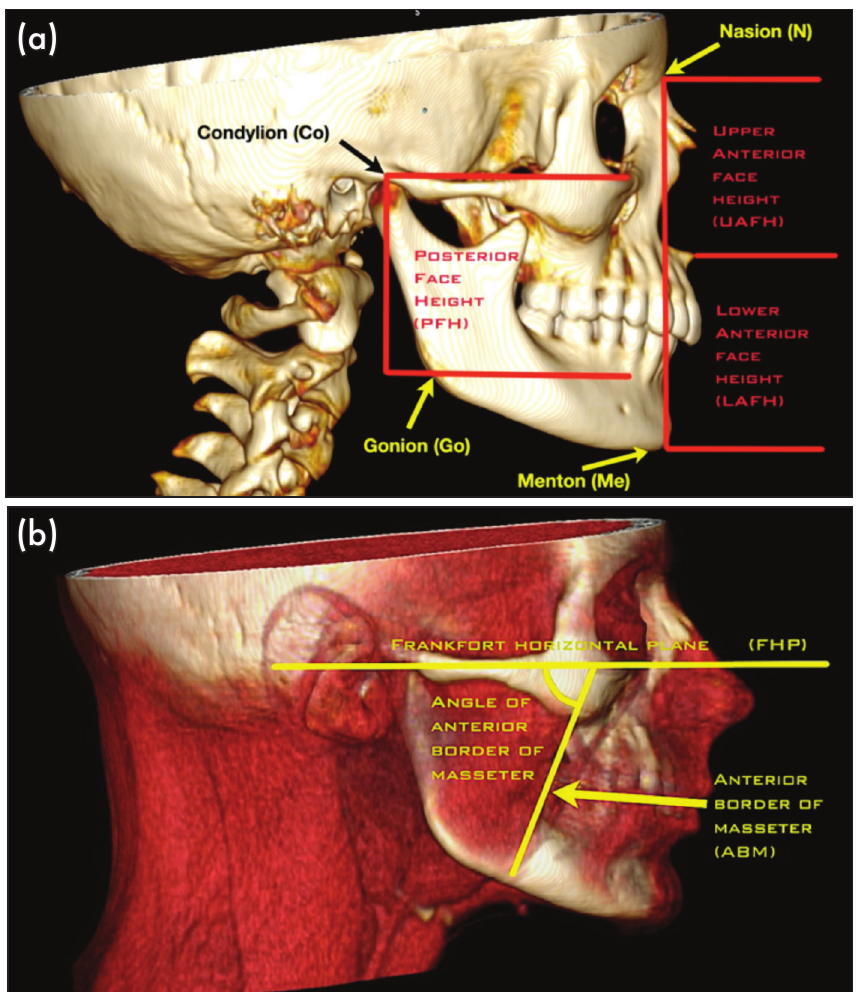
Figure 1. Examples of measurements taken from the right lateral profile, using the volume-rendering 3D-CT technique: (a) skeletal view; (b) muscular